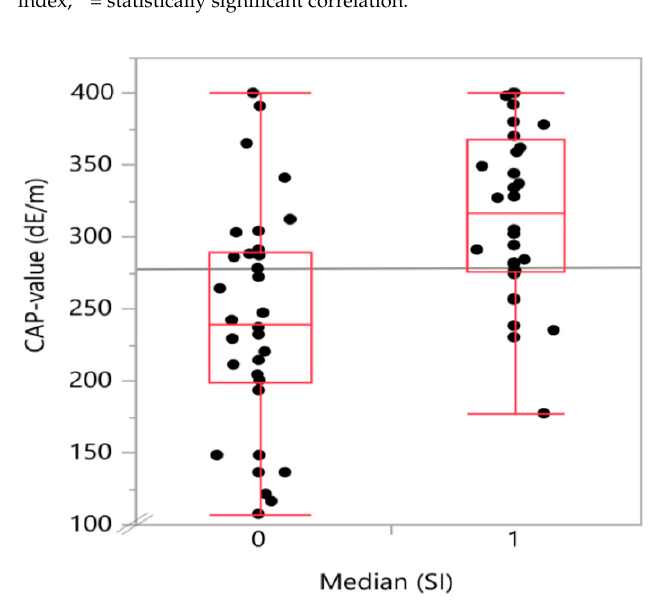
Figure 2. Boxplot with the distribution of CAP-value (continuous attenuation parameter-value) on transient elastography in the two snoring index groups divided into above (1) or below (0) median SI (snoring index). The group of patients with above median snoring index showed significantly higher CAP-values.